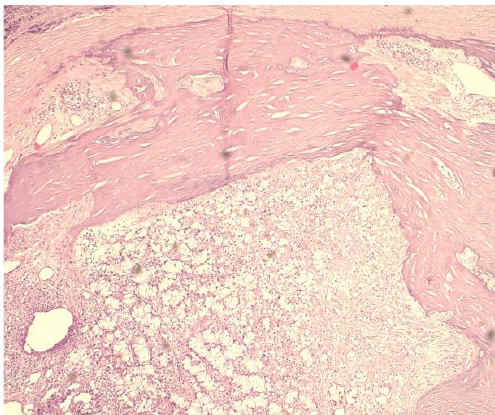
Figure 3. Clear cell proliferation with association of focal areas of intralesional necrosis (H and E, ×40).